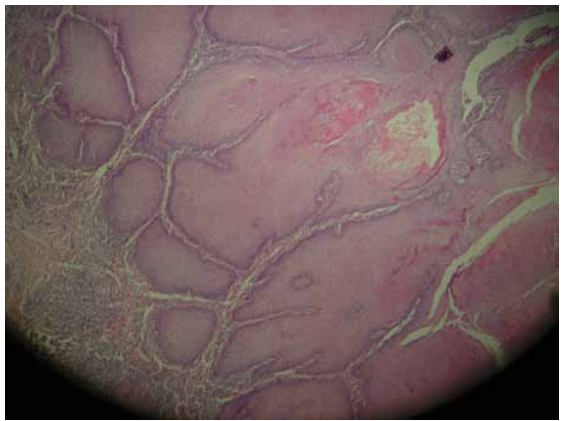
Figure 5. Penetrating growth in the form of thick, claviform verrucas and blunt, wide indentations into the stroma. Parakeratin fills indentations of the epithelium. Hematoxylin-eosin staining (HE). Magnification 40x